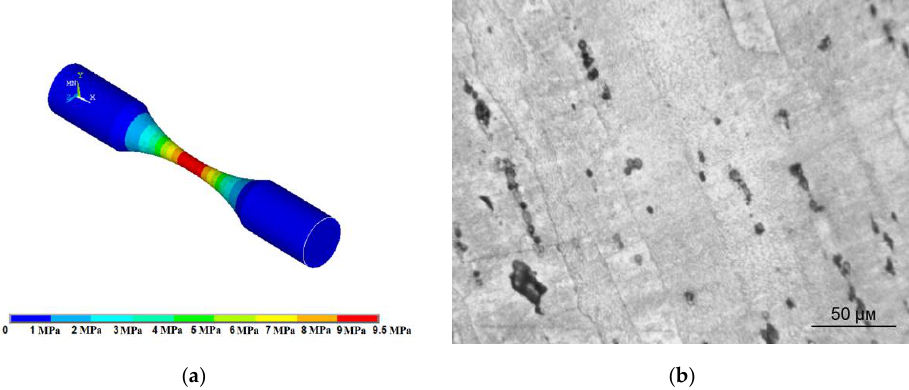
Figure 6. The stress distribution in hot-rolled specimens ( a ) and corresponding microstructure ( b ).